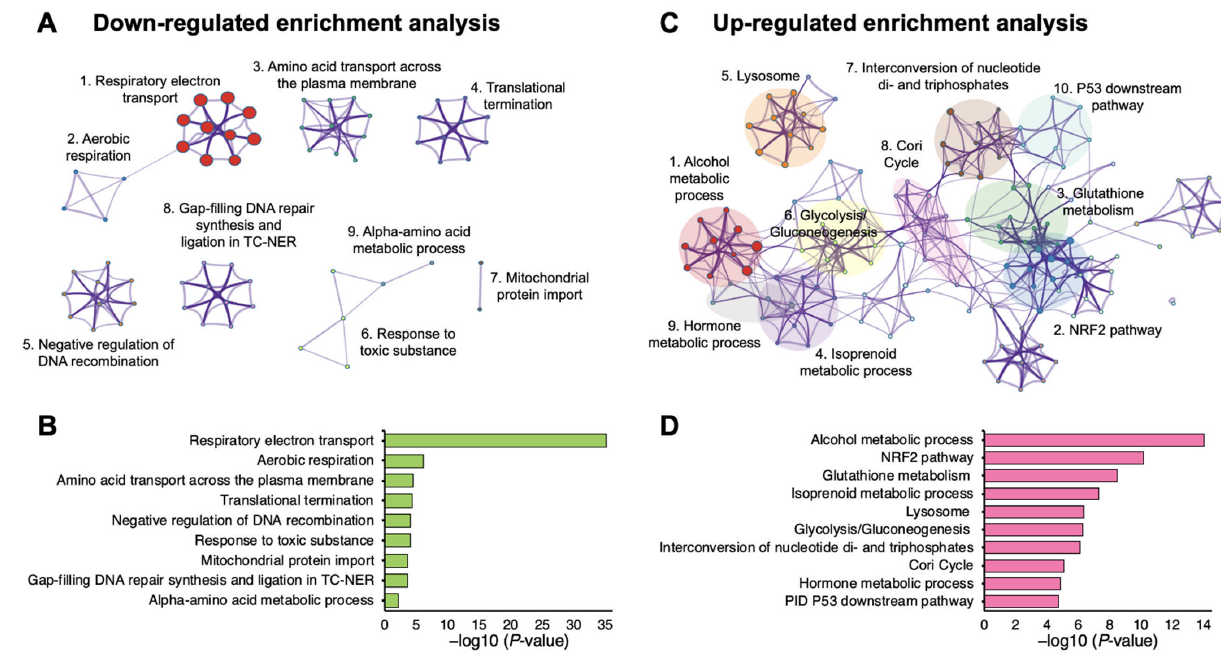
Figure 3. Functional enrichment analysis of differentially expressed proteins of MO treatment compared to control treatment using Metascape. ( A , C ) Network of enriched pathways of downregulated ( A ) and upregulated ( C ) proteins of MO treatment compared to control. Each node and its size represent a statistically enriched pathway and the number of enriched proteins on each node pathway, respectively. The clusters of similar pathways are labeled with the same color. ( B , D ) Bar charts plot the cluster significance of enriched pathways of downregulated ( B ) and upregulated ( D ) proteins in MO treatment. Each bar showed top one of each enriched cluster pathways. Annotations refer to the gene ontology biological processes (GOBP), Reactome, KEGG, canonical pathways, and WikiPathways. The top pathways ranked by their significance ( − log 10 p ‐ value) are shown. The detail information for enriched pathways was listed in Supplementary Tables S3 and S4.